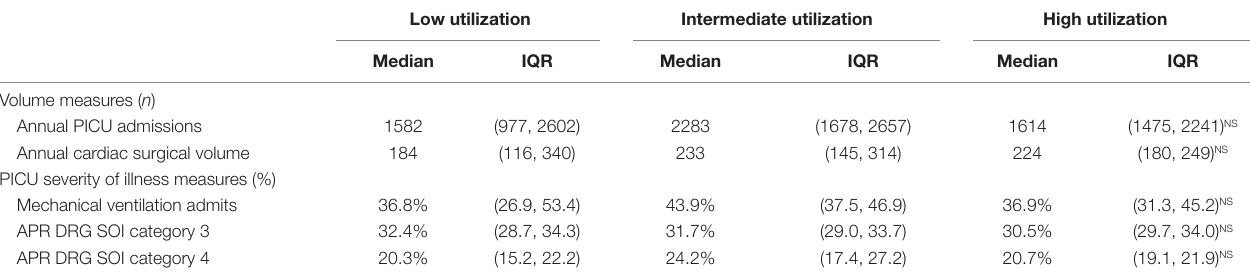
TaBle 2 | hospital characteristics among intermediate, high, and low utilization hospitals.